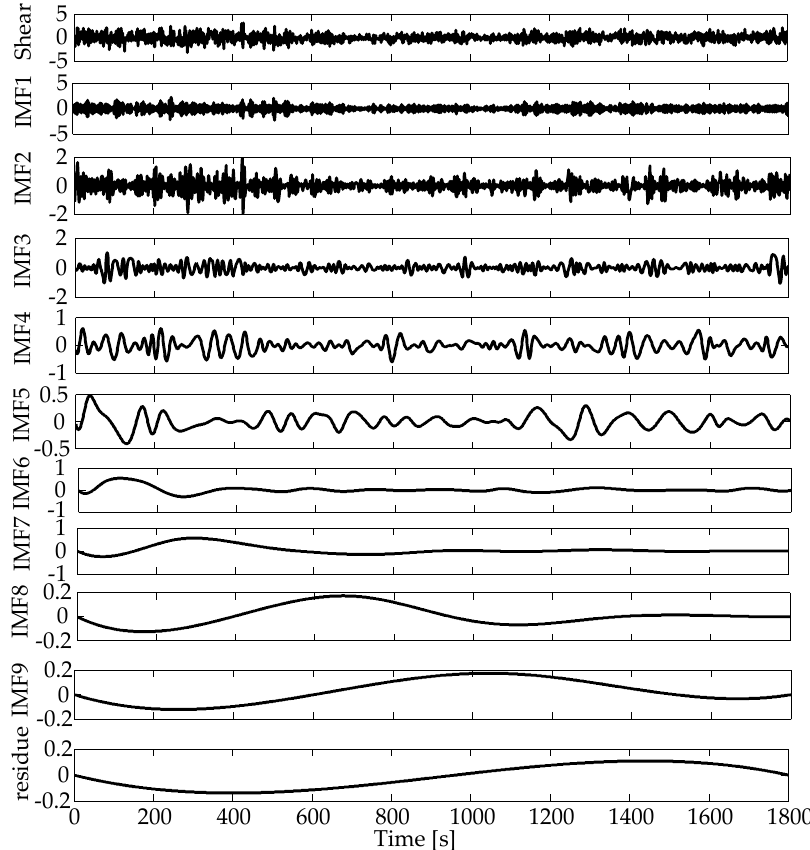
Figure 7. Comparison of the velocity shear signal and the nine IMF modes, as well as the residue.